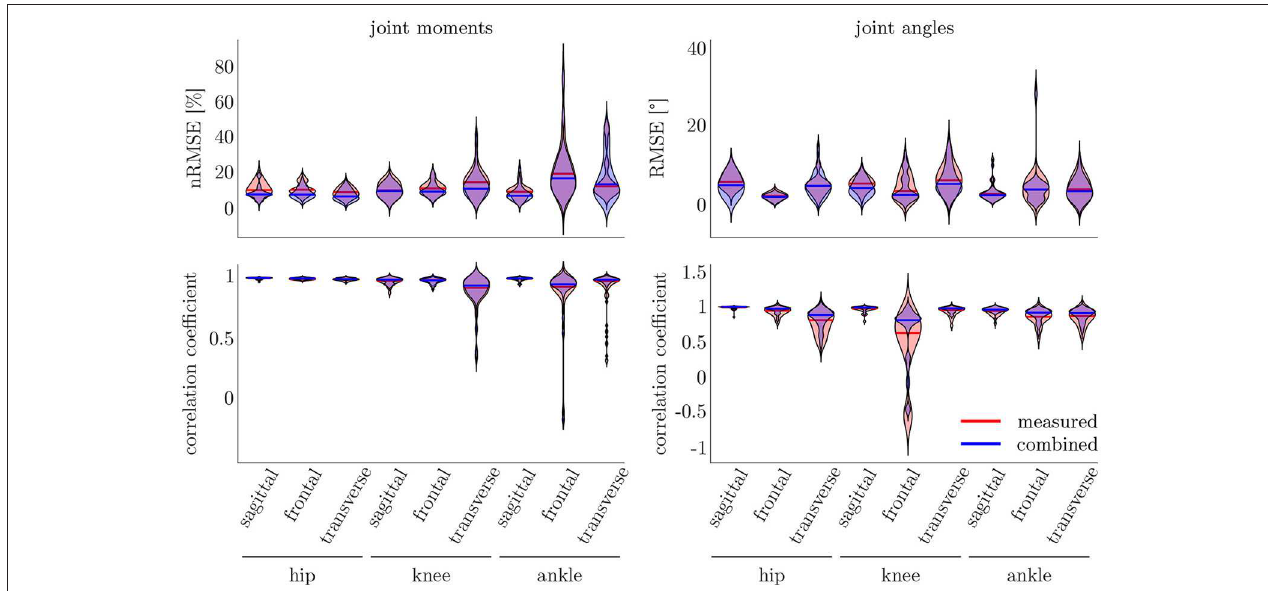
FIGURE 9 | On the right, the distribution of the RMSE and the correlation coefficient for the kinematic data is displayed. On the left, the distribution of the nRMSE and the correlation coefficient for the kinetic model can be found. The results for the measured data as inputs is displayed in red, while the results for the combined data inputs are displayed in blue. The violin’s width displays how much data is accumulated, while the height shows the range of the distribution. The horizontal line indicates the median value of the